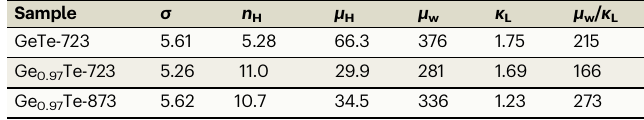
Table 1 | Thermoelectric transport parameters at room tem- perature for the GeTe and Ge 0.97 Te samples Sample